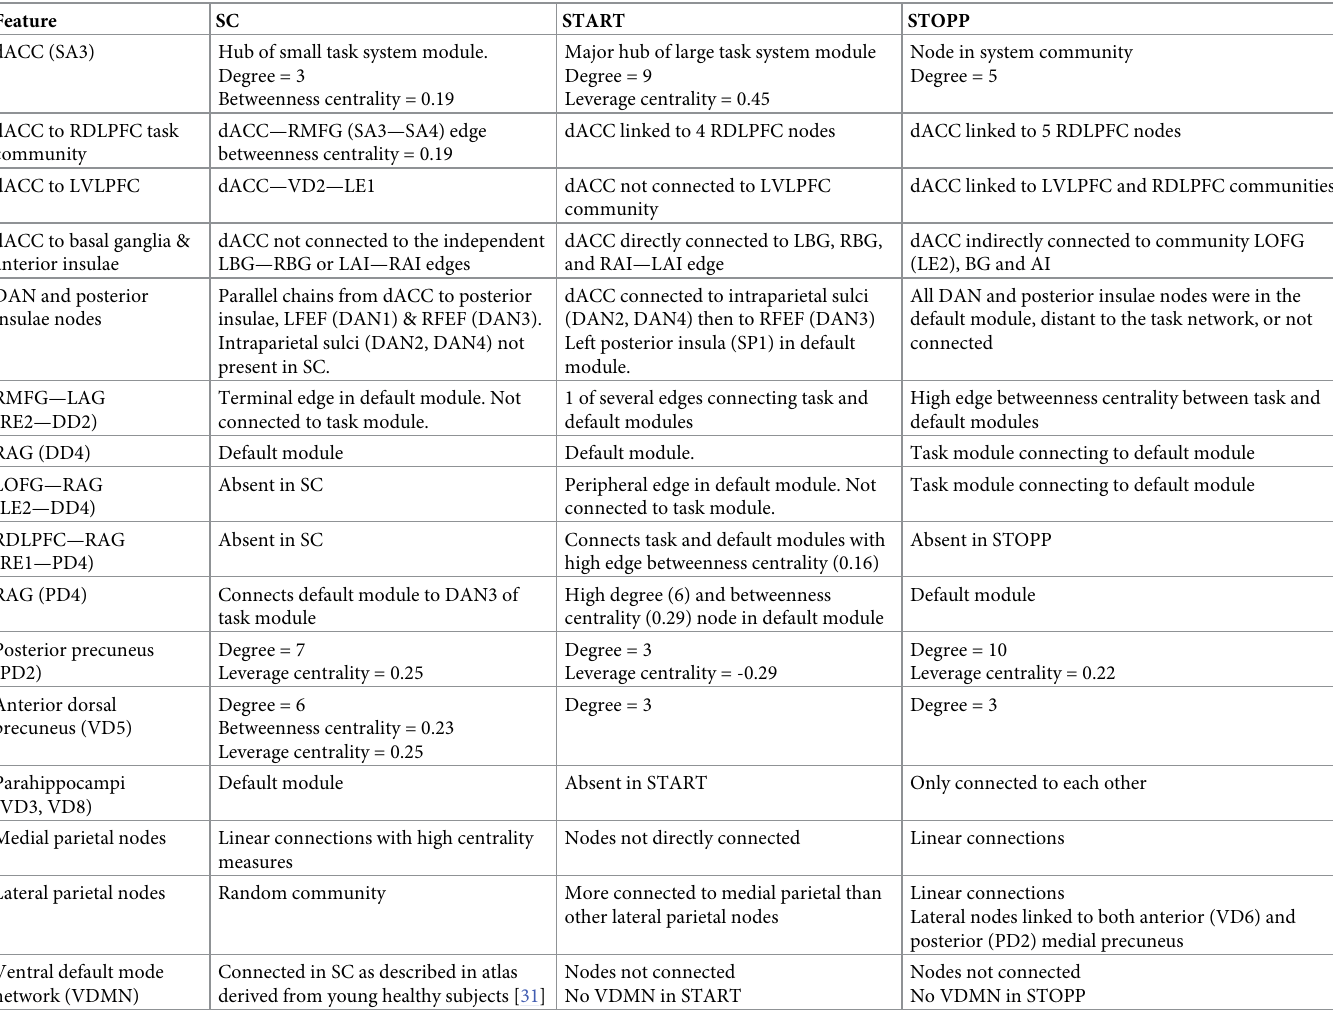
Table 3. Summary of qualitative differences in connectivity between SC, START and